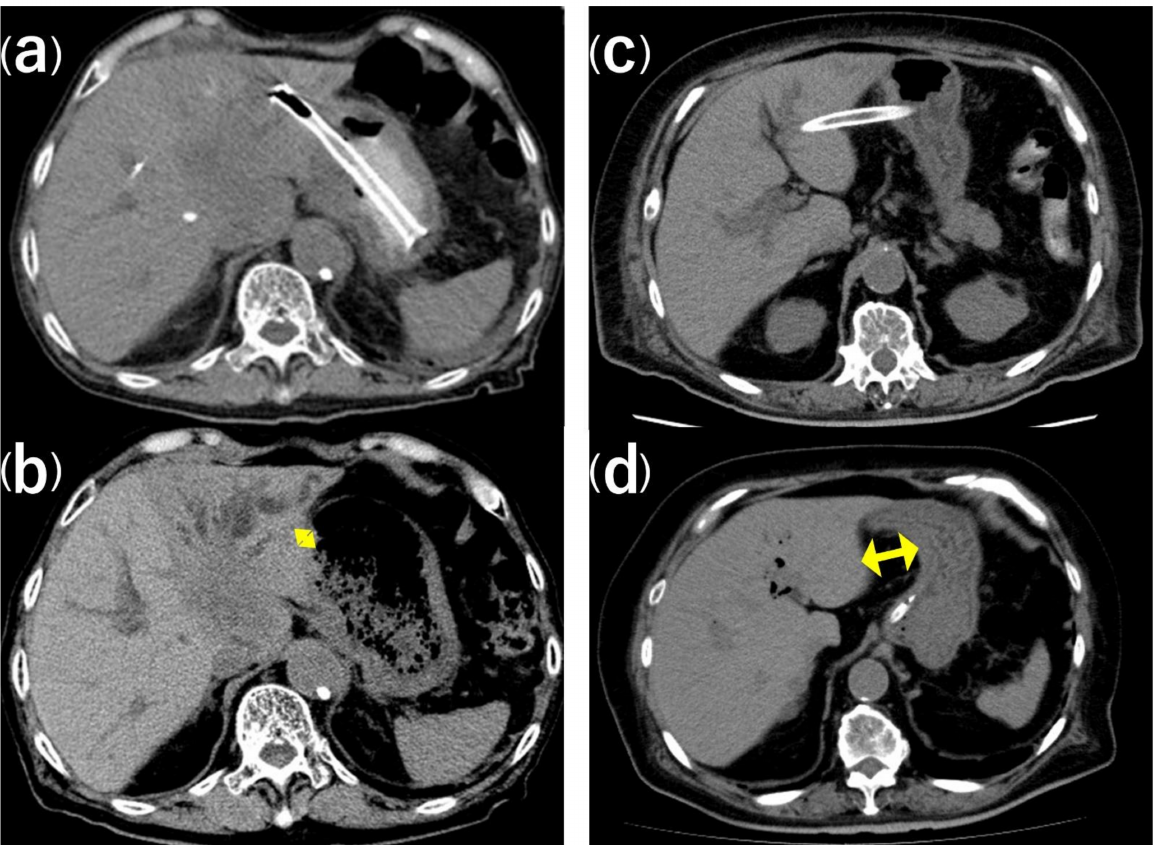
Figure 1. The distance between the puncture site and stomach, as revealed by CT before and after EUS-HGS. ( a ) In the non-migration group, the post-EUS-HGS distance between the puncture site and stomach was short. ( b ) The double yellow arrow denotes the short initial distance between the puncture site and stomach in the non-migration group. ( c ) In the stent migration group, the post-EUS-HGS distance between the puncture site and stomach was long. ( d ) In the stent migration group, the distance between the puncture site and stomach was significantly longer than in the non-migration group.